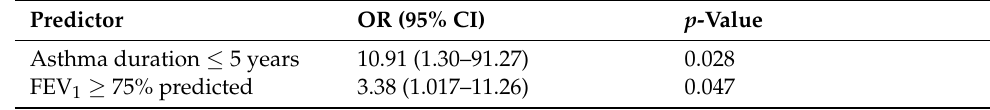
Table 4. Predictors of clinical remission to biologics.